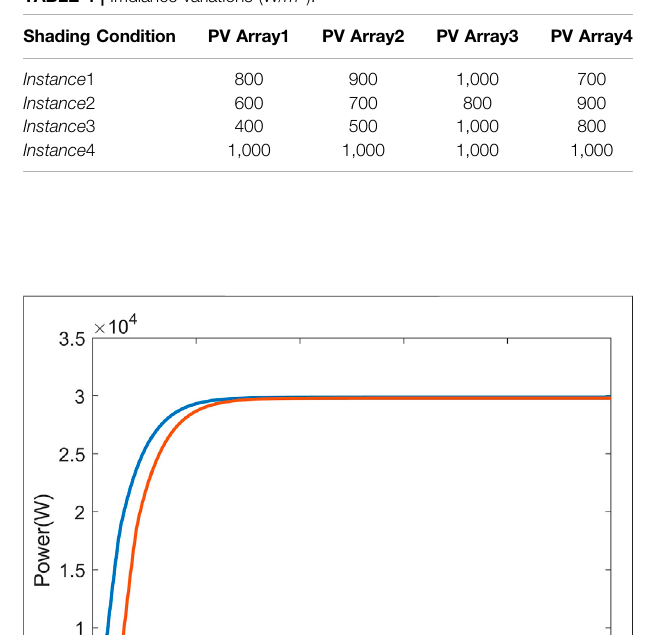
TABLE 3 | Particle swarm optimization parameters. TABLE 4 | Irridiance variations (W/ m 2